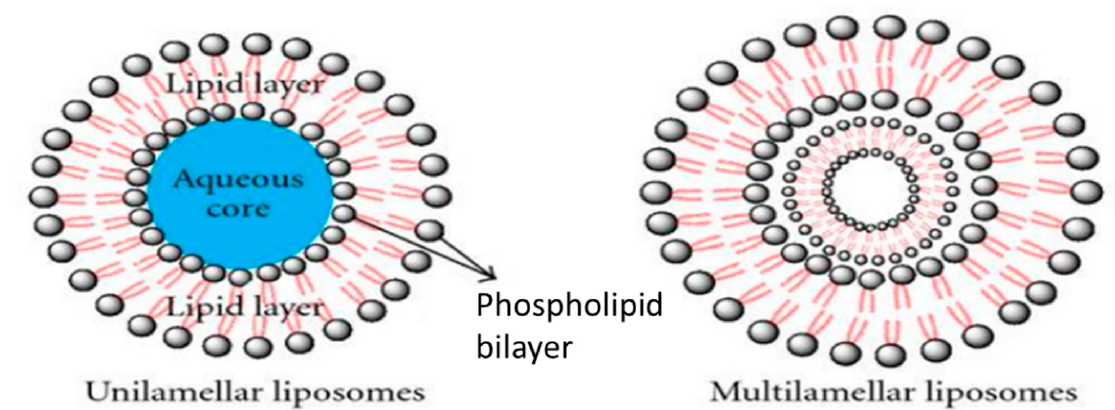
Figure 6. Schematic representation of Liposomes. Adapted from [69], Journal of Drug Delivery, 2011.